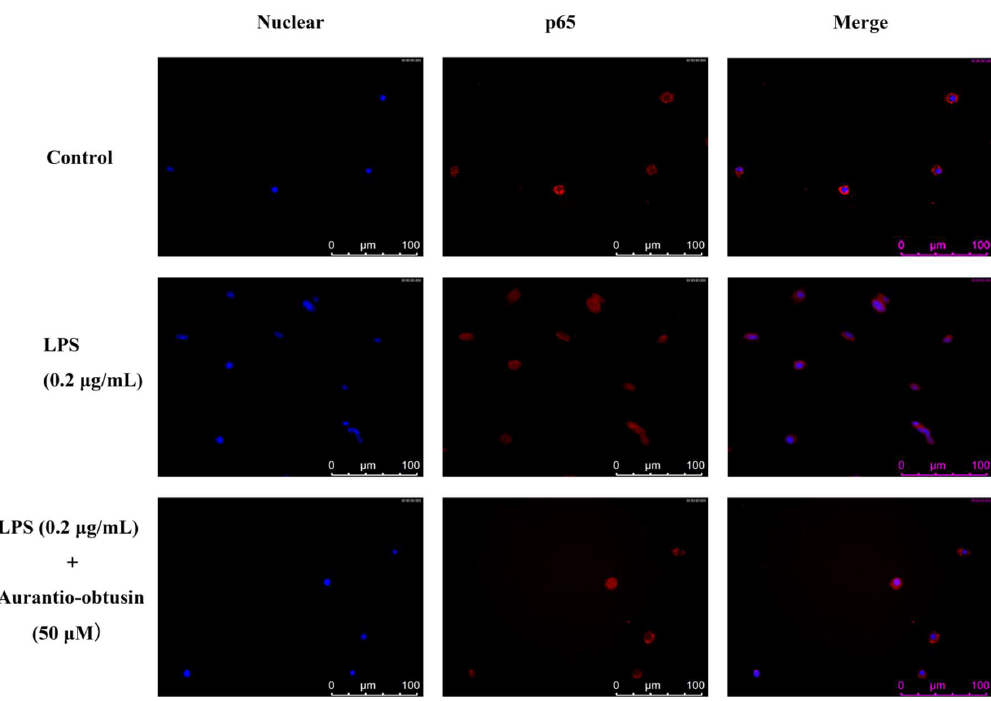
Figure 7. Nuclear localization of the p65 subunit of NF- κ B was analyzed through immunofluorescence. Briefly, cells were fixed with 4.0% formaldehyde and permeabilized by incubating them with 0.1% Triton X-100. The cells were incubated with anti-NF- κ B p65 antibodies overnight at 4 ◦ C, and then with Cy3-labeled Goat Anti-Rabbit IgG for 1h at room temperature in the dark. Next, the cells were incubated with DAPI mounting medium for 10 min and the images were captured under a microscope. Fluorescent images of the cytoplasmic and nuclear fractions were merged to locate p65. Aurantio-obtusin inhibited the trans-location of p65 into the nucleus.